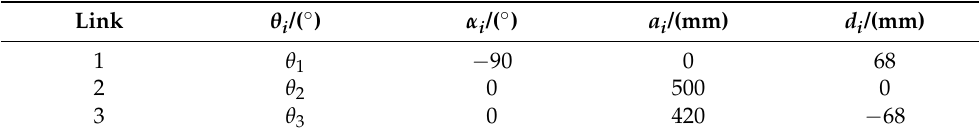
Figure 3. Diagram of the coordinate system of each linkage of the robot arm. Table 1. D-H parameters table of the EBULRR.